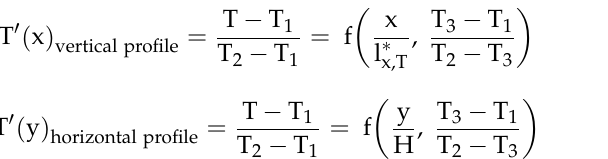
Figure 8. Universal surfaces of the temperature field (Expression (23)) for π T